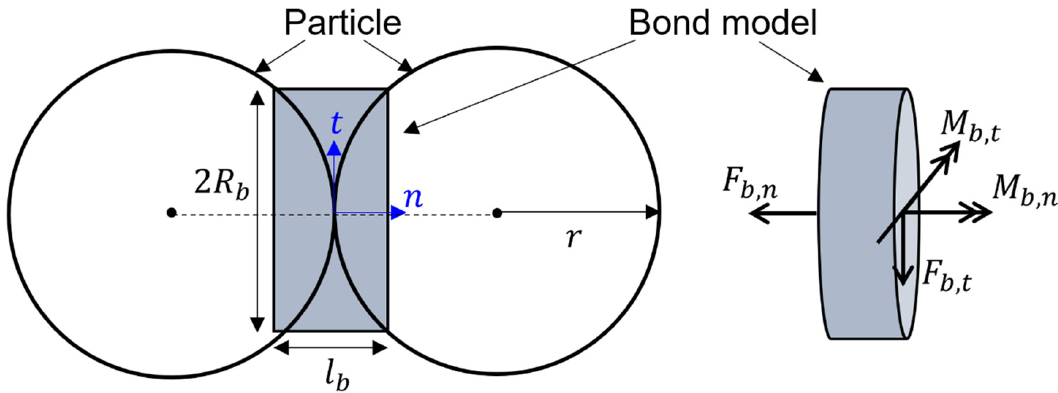
Figure 1. Bond model between two spherical particles.